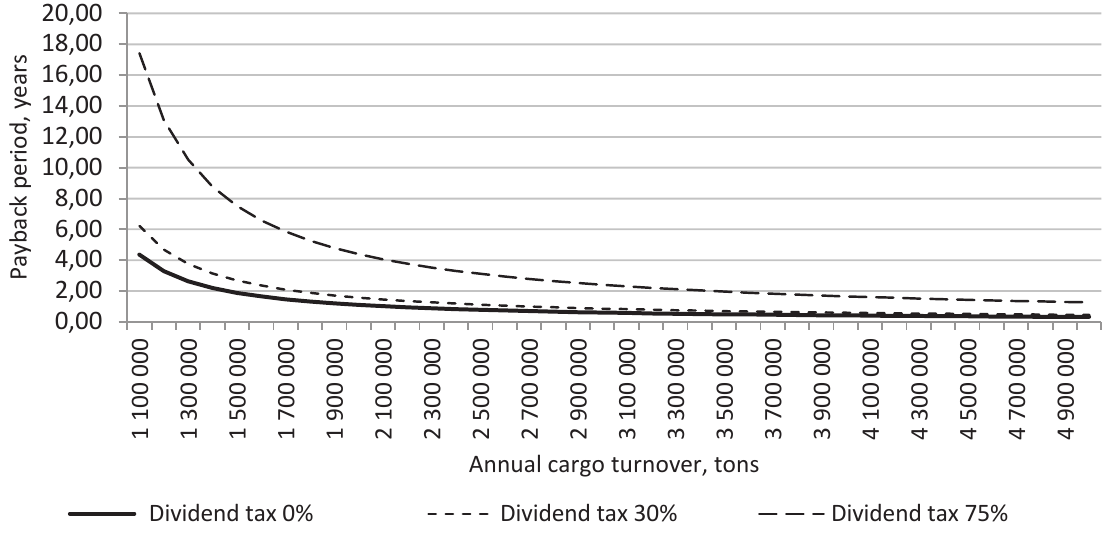
Figure 1. The value of the payback period on investment projects depending on the annual cargo turnover and the rate of taxation on